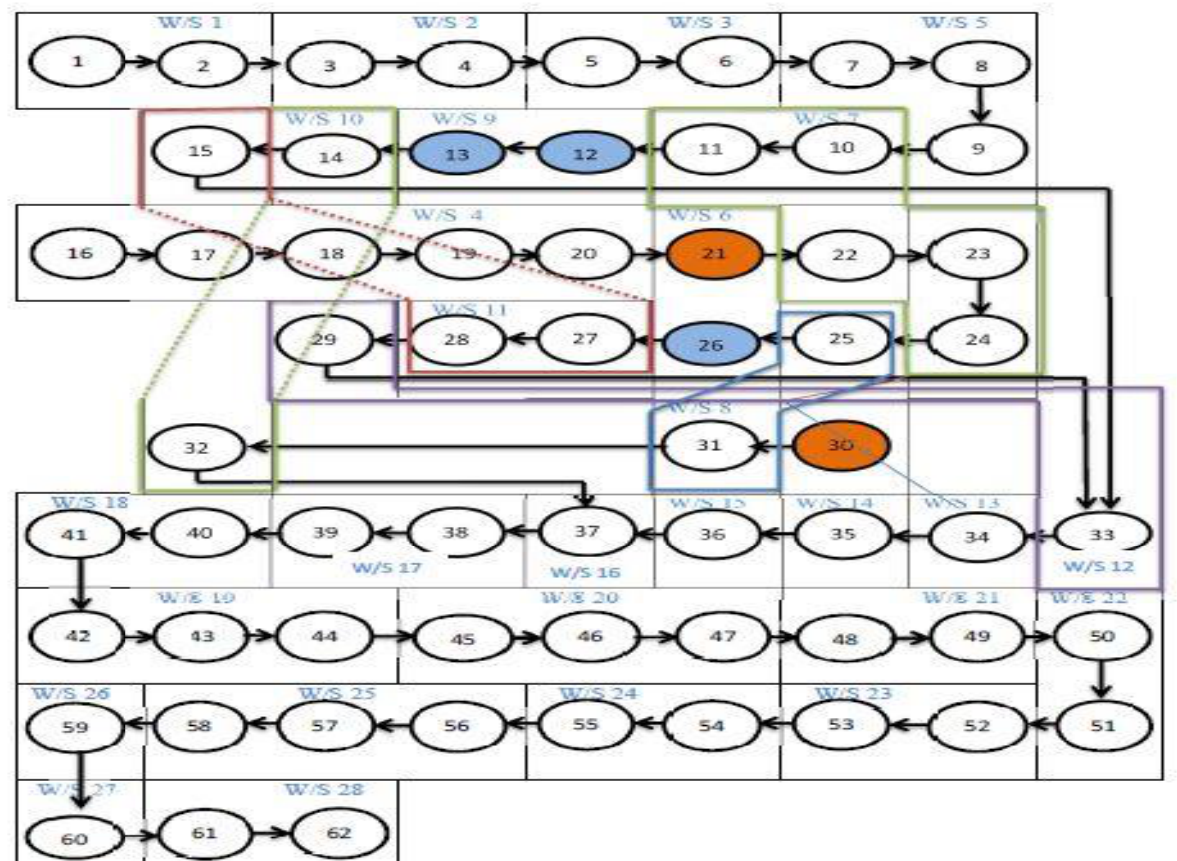
Figure 5. Assignment of work element according to RPW